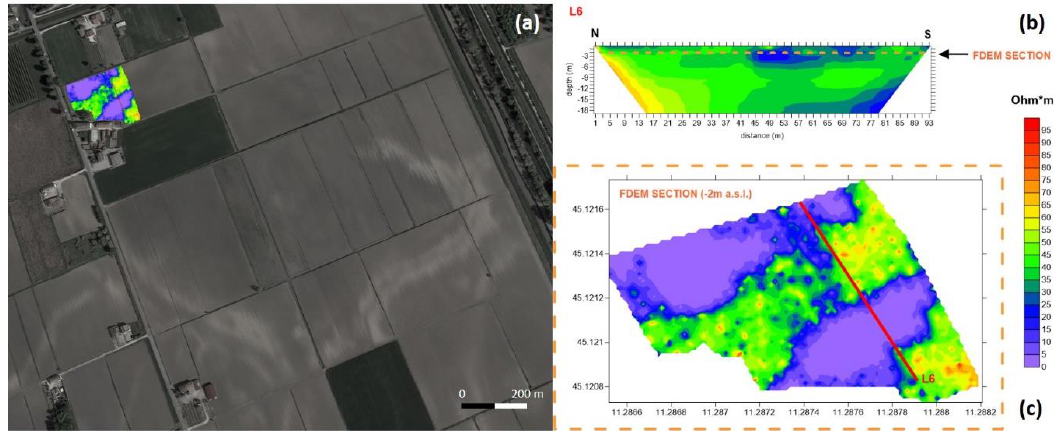
Figure 9. ( a ) Overlap of FDEM results with ERT L6 position in Google Earth image (2005); ( b ) ERT L6 and FDEM map ( c ) at −2 m a.s.l. (with default range of resistivity). The integration between ERT and FDEM methods allows us to also answer question c positively.